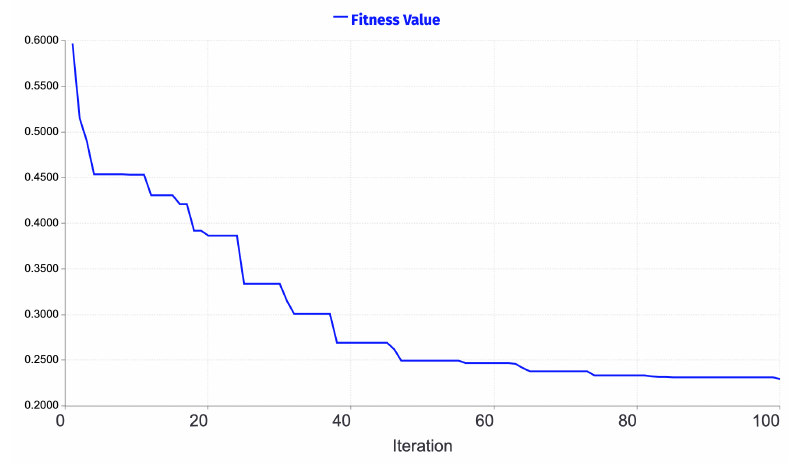
Figure A3. The training convergence curve when using the ANN with the PSO and the cost sensitivity fitness function for the dataset of Spanish companies.